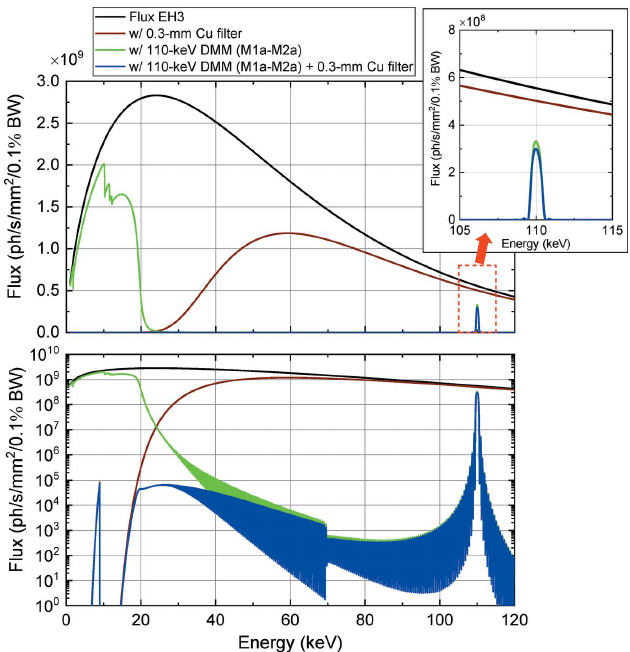
Figure 5 Calculated photon flux densities at EH3 under various conditions. The black line represents the photon flux density generated by the source. The green and brown lines represent the densities obtained using the 110 keV DMM (M1a–M2a) and 0.3 mm Cu filter, respectively. The blue line represents the density obtained using both the 110 keV DMM and 0.3 mm Cu filter. The inset depicts an enlarged representation of the plot enclosed in the dashed square. The vertical axes of the graphs are drawn in linear (upper) and log (lower)